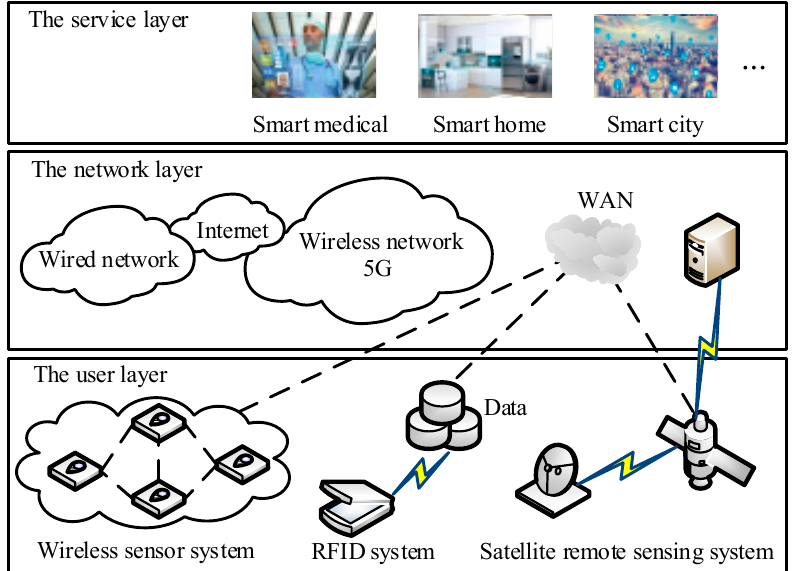
Figure 2. The architecture of 5G IoT.